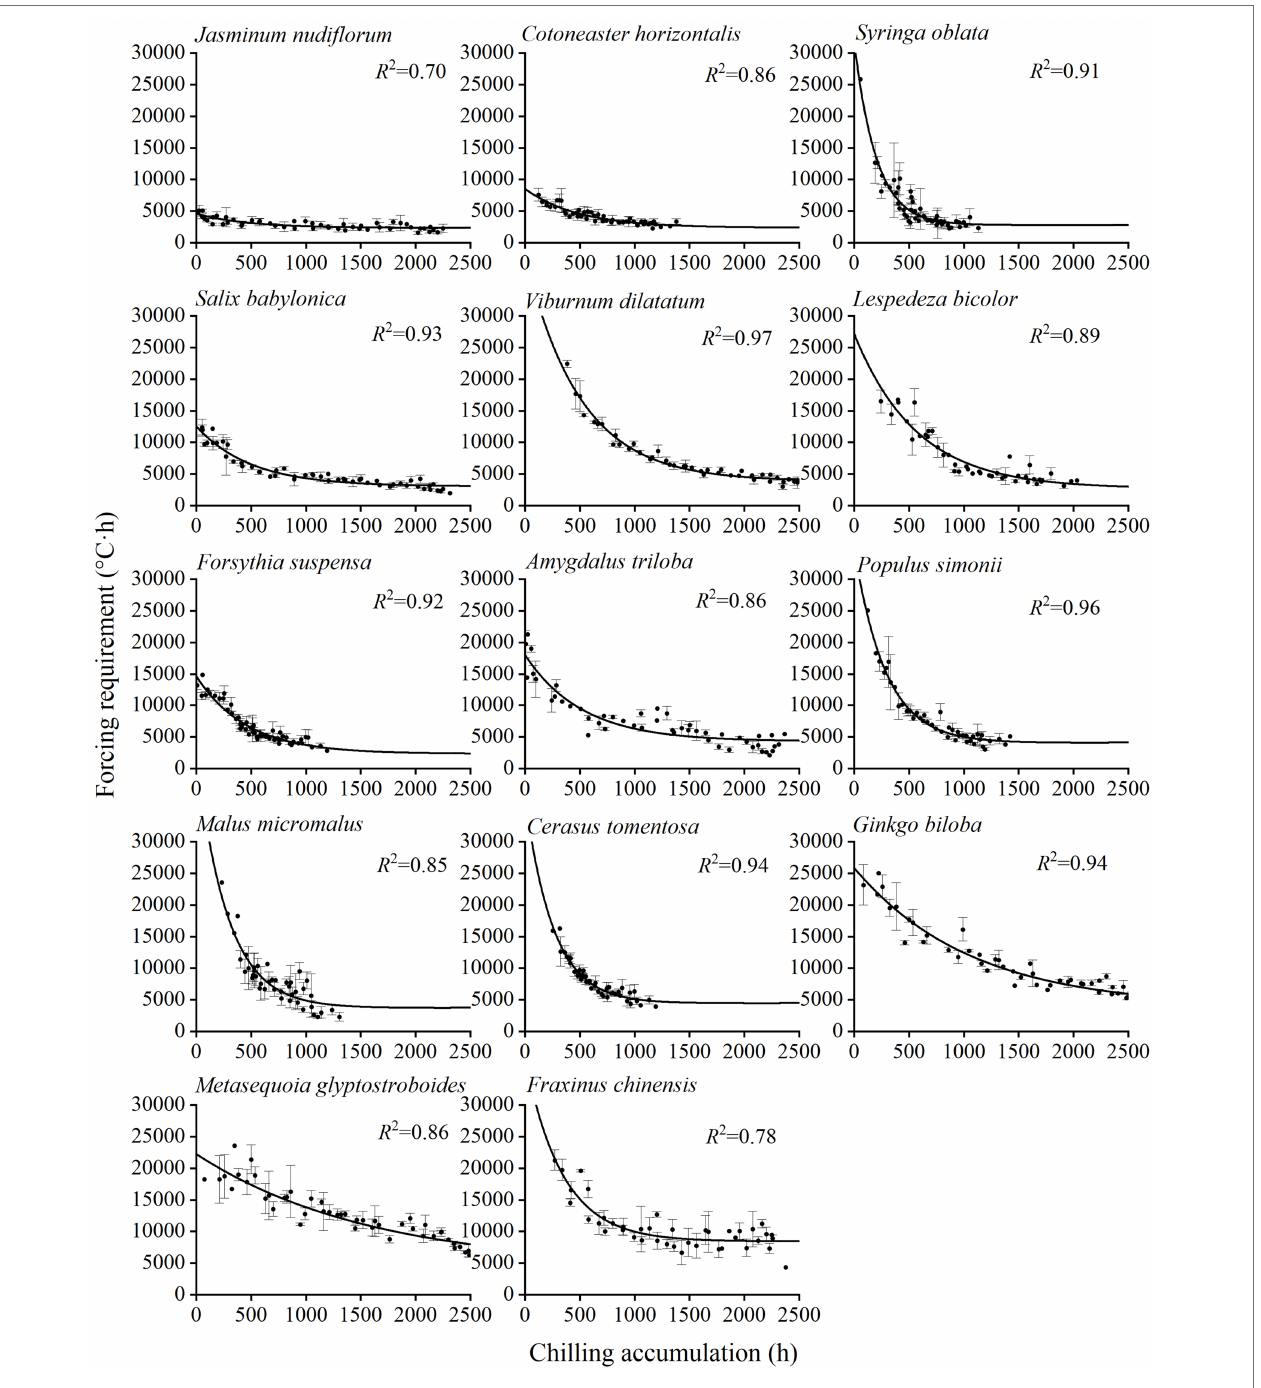
FIGURE 2 | Relationship between the forcing requirement (FR) of spring events and chilling accumulation (CA) for 14 woody species. Points: observed CA and FR in the two-year experiment. Error bar: SD. An exponential function is fitted for each species, and the coefficient of determination ( R 2 ) is shown. The CA for each species is based on different chilling models ( Table 1